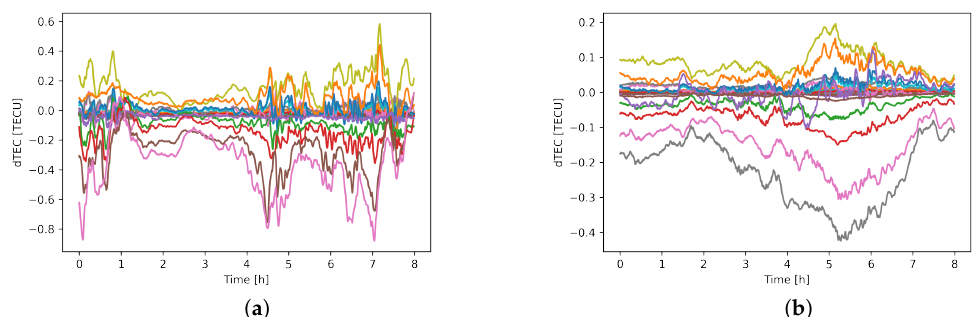
Figure 1. Differential Total Electron Content (dTEC) variations with time for LOFAR baselines; ( a ) observation L79324, ( b ) observation L82655.